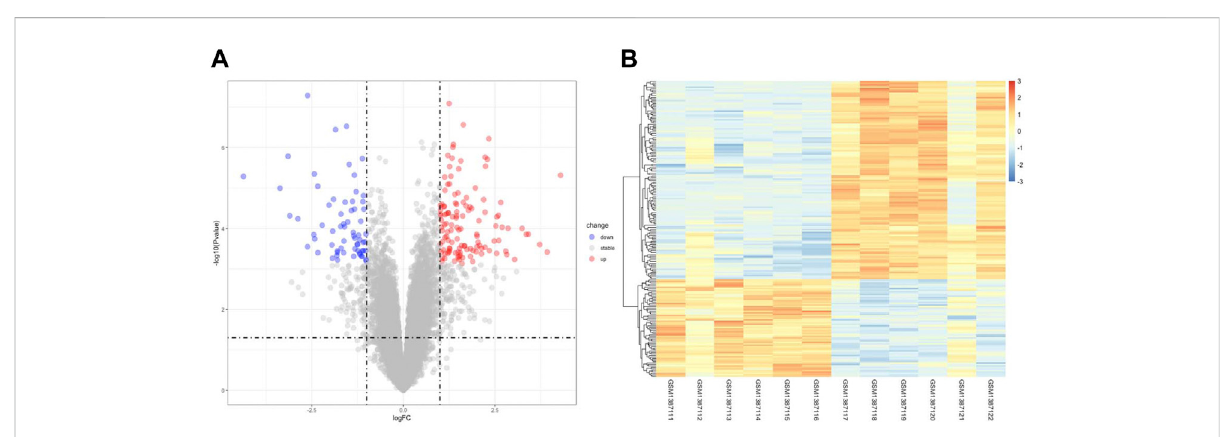
Identi fi cation of DEGs Associated with OE. (A) the volcano plot of DEGs, red dots indicate upregulated genes and blue dots indicate downregulated genes in OE tissue. (B) the heatmap of DEGs, different colors in the heatmap represent the trend of gene expression in different